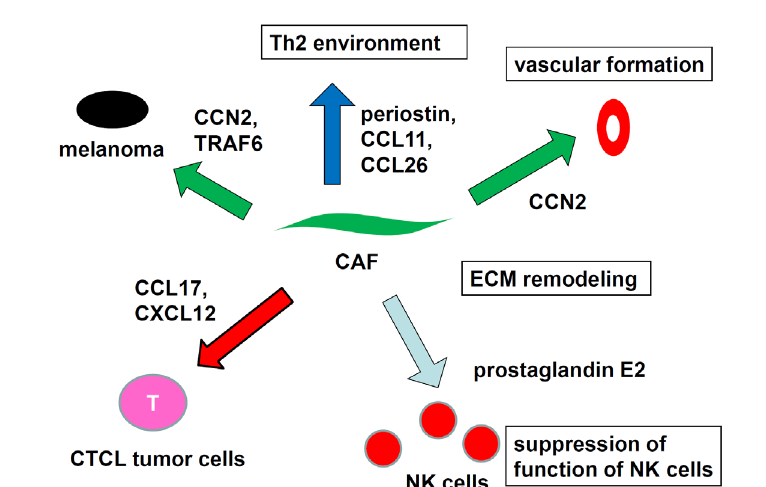
Figure 6. Role of fibroblasts in skin malignancy. Fibroblasts express cytokines, inducing progression of skin malignancy Suppression NK functions and establishment of Th2-dominant microenvironment also contribute to the